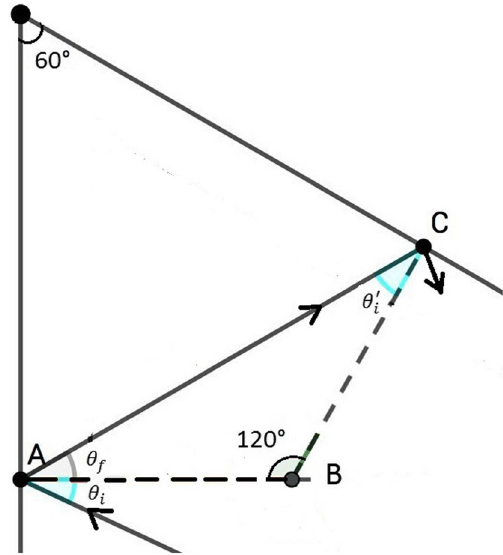
Fig. 4 Relation between the angles of incidence of two following bounces: θ i and θ (cid:11) . Here we can see that the condition θ f + θ (cid:11) i must hold in order to have 180 ◦ as the sum of internal angles of the tri- (cid:18) BC . It follows that the initial condition θ i + θ f = 60 ◦ implies angle A θ = θ (cid:11) for every couple of subsequent bounces i i